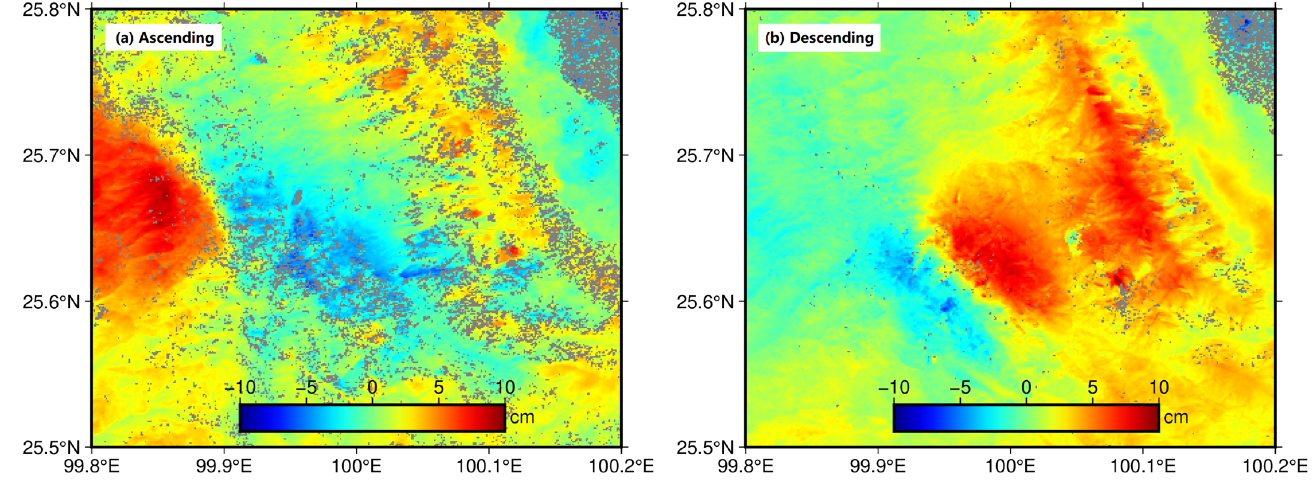
Figure 2. The ascending and descending coseismic deformation field of the Yangbi Ms 6.4 earthquake: ( a ) the ascending coseismic deformation field; ( b ) the descending coseismic deformation field.